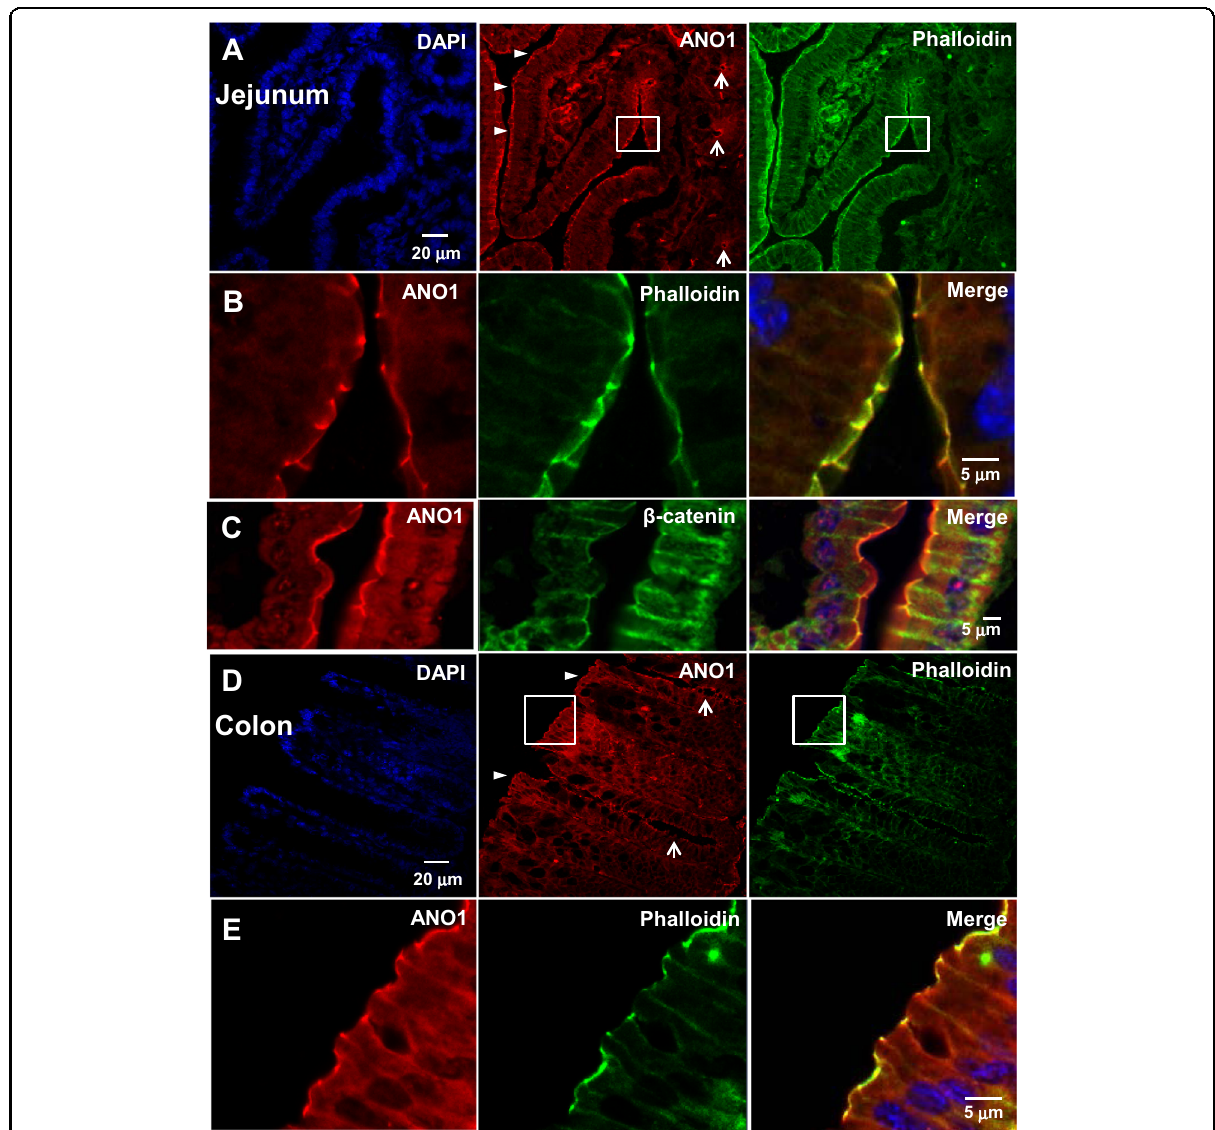
Fig. 3 ANO1 is expressed in the apical membranes of the small intestine and colon. a – e Immuno fl uorescence images of the jejunum ( a – c ) and colon ( d , e ) stained with antibodies speci fi c for ANO1, as well as phalloidin and β -catenin, markers for apical and lateral membranes, respectively. Arrowheads indicate the strong expression of ANO1 in the apical membrane of villi and surface epithelial cells in the jejunum ( a ) and colon ( d ). ANO1 showed relatively weak expression in the apical membrane of the crypt in the jejunum and colon (arrows) compared to the villi and surface region (arrowheads). b , c , e Magni fi ed images of epithelial cells in the square regions of ( a ) and ( d ). ANO1 was largely colocalized with phalloidin at the apical membrane ( b ) but was not colocalized with β -catenin, which is the lateral membrane marker ( c